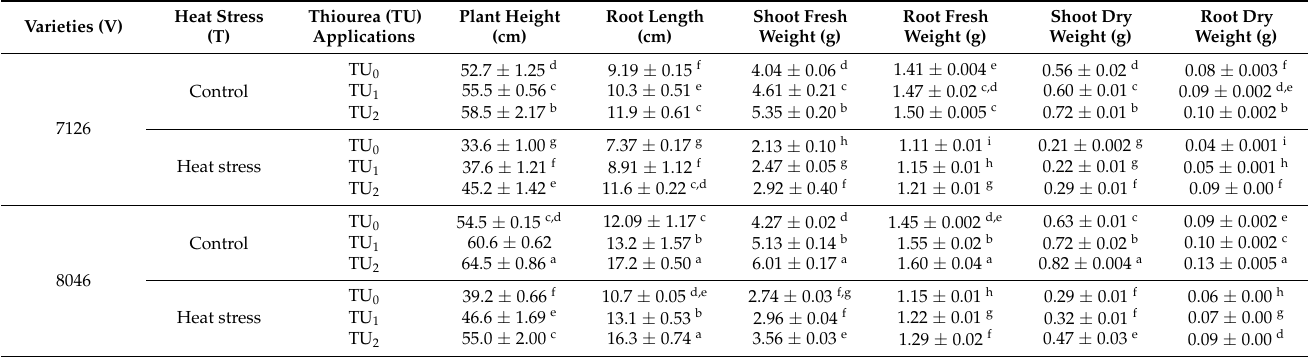
Table 1. Impact of thiourea priming and heat stress on growth parameters of two camelina varieties. Varieties (V) Heat Stress